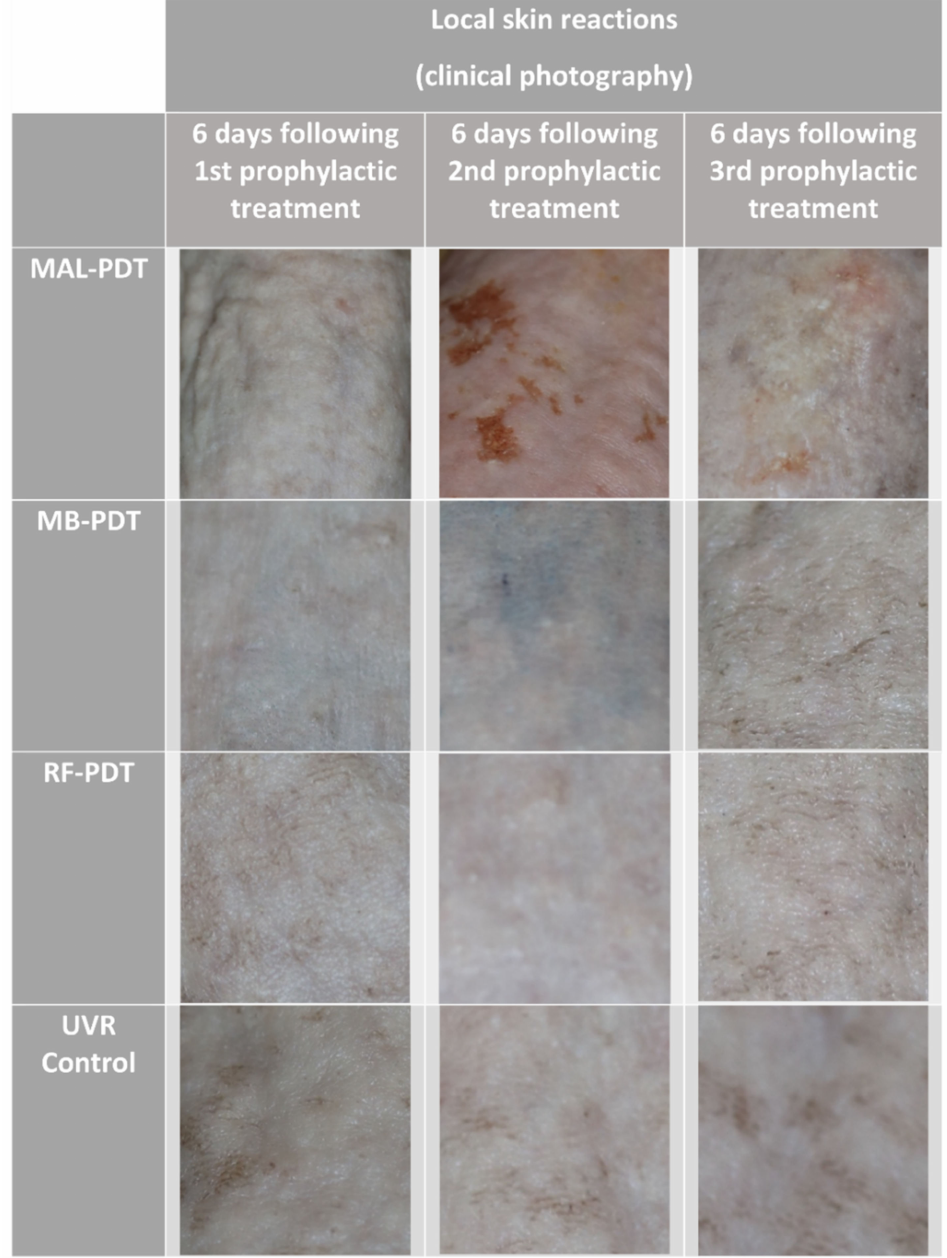
Figure 2. Clinical reactions after the prophylactic treatments. Abbreviations: MAL, methyl aminole- vulinate; MB, methylene blue; RF, riboflavin; PDT, photodynamic therapy; UVR, ultraviolet